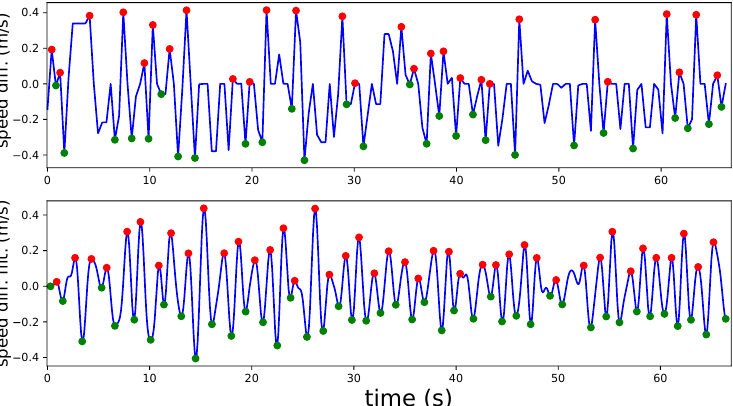
Figure 8. Contact heel detection (red/green dots) over leg v dif f signal and over filtered version.